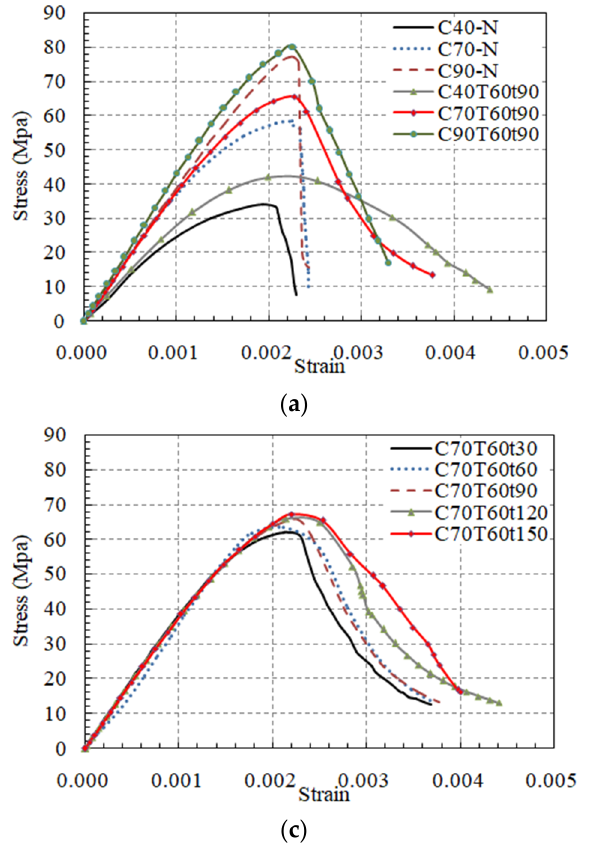
Figure 6. Stress–strain curves of SSC: ( a ) unconditioned and conditioned specimens; ( b ) specimens with various target temperatures; ( c ) specimens with various cycling times.